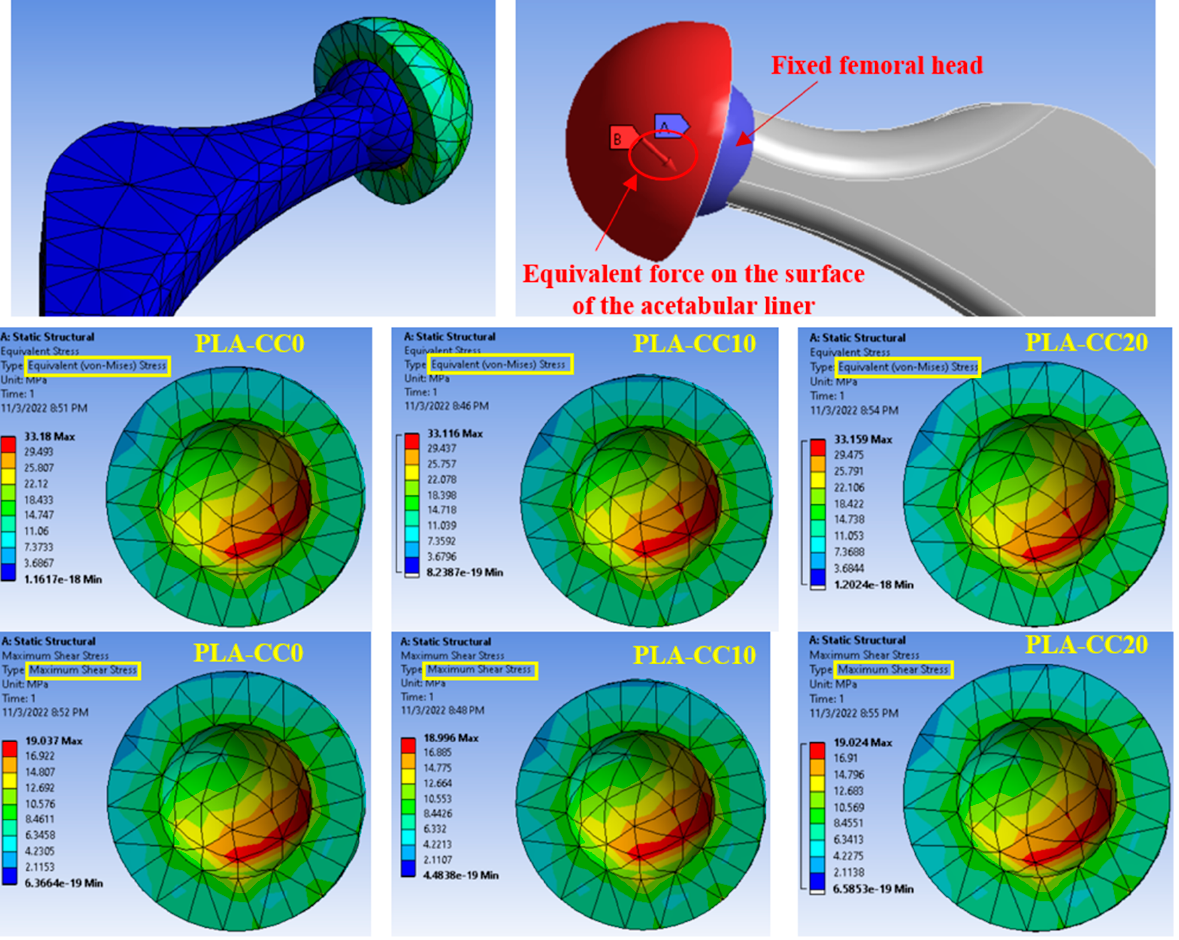
Figure 12. FEM of a hip joint and the different induced stresses.